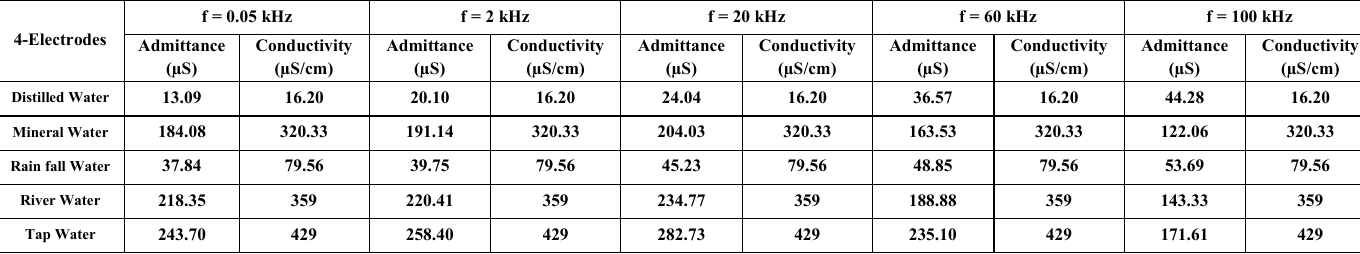
Table (1): Calculated values of admittance and measured conductivity for different frequencies by the 4-electrode system